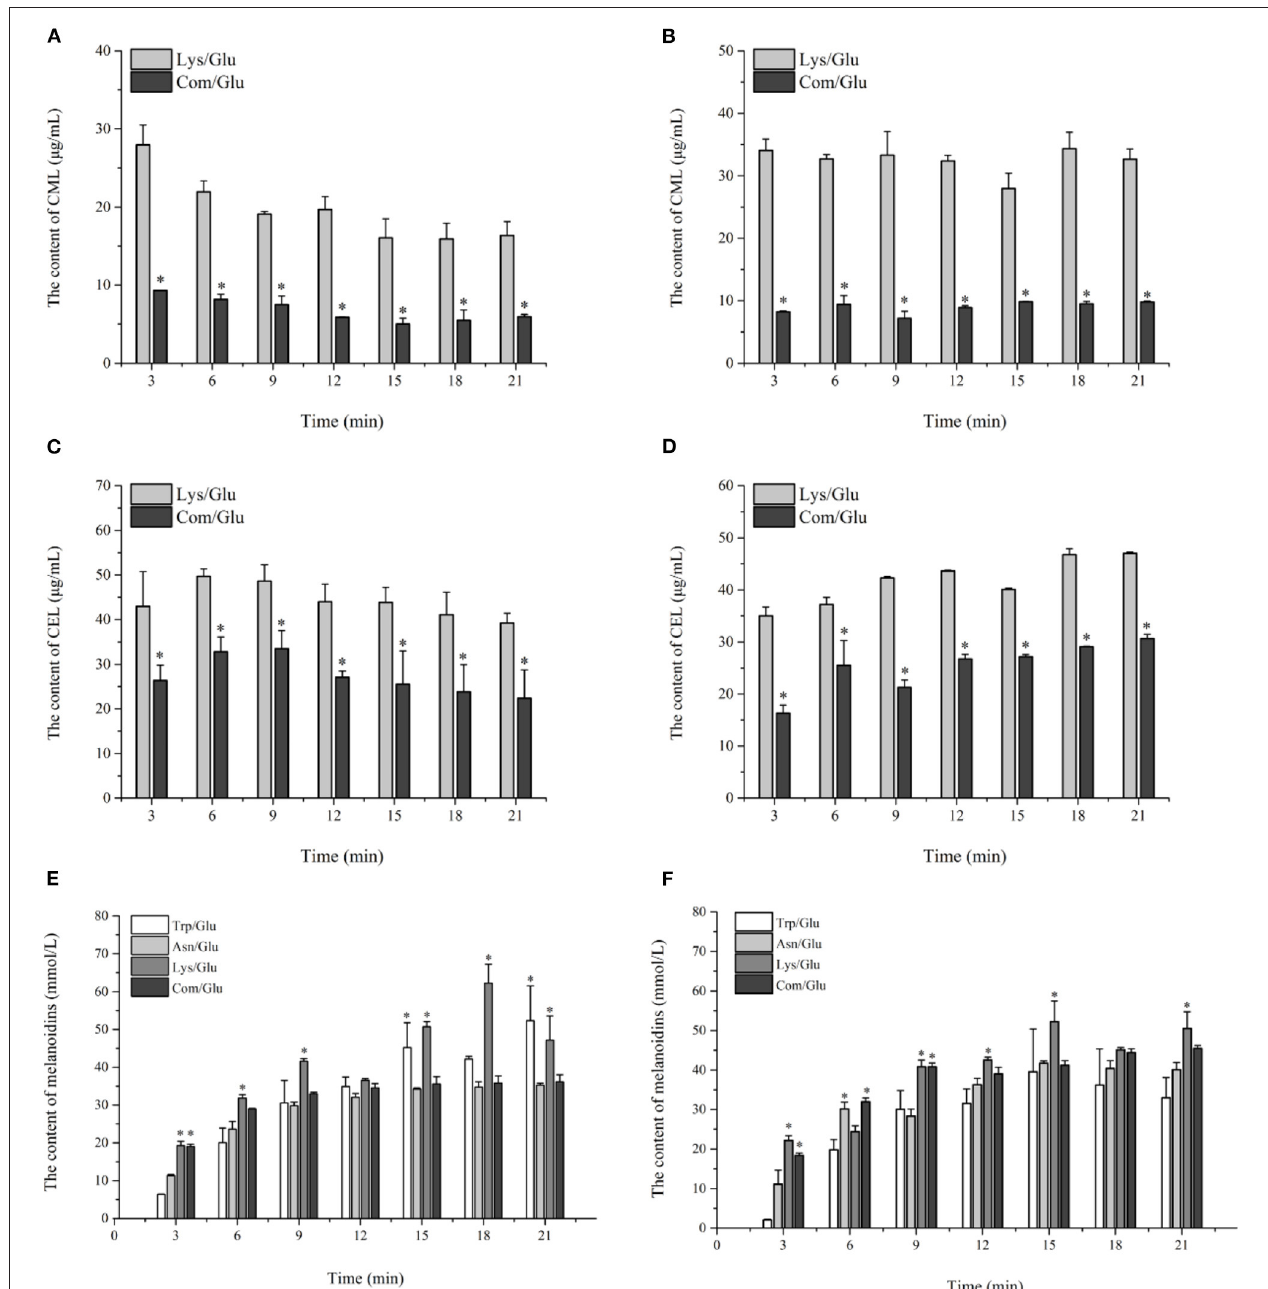
FIGURE 5 | Kinetic profiles of Maillard reaction products includes CML (A,B) , CEL (C,D) , and melanoidins (E,F) in the different amino acid/glucose model system heated at 170 ◦ C (A,C,E) and 200 ◦ C (B,D,F) . Data were expressed as mean ± SD in triplicates ( n = 3), *, ( P < 0.05).